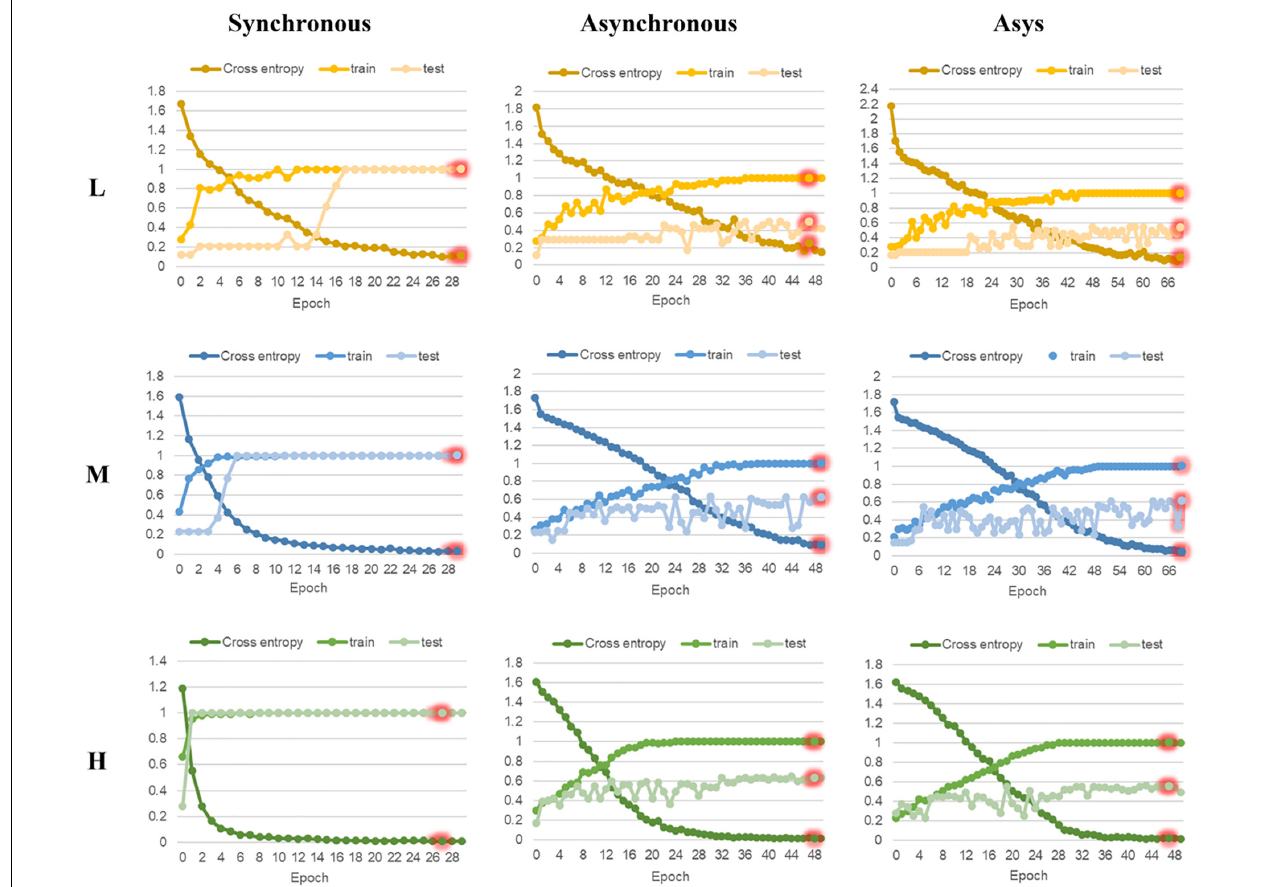
FIGURE 7 | The accuracy curves and cross-entropy cost function of ResNet models based on region data with different sample size. L, low sample size; M, medium sample size; H, high sample